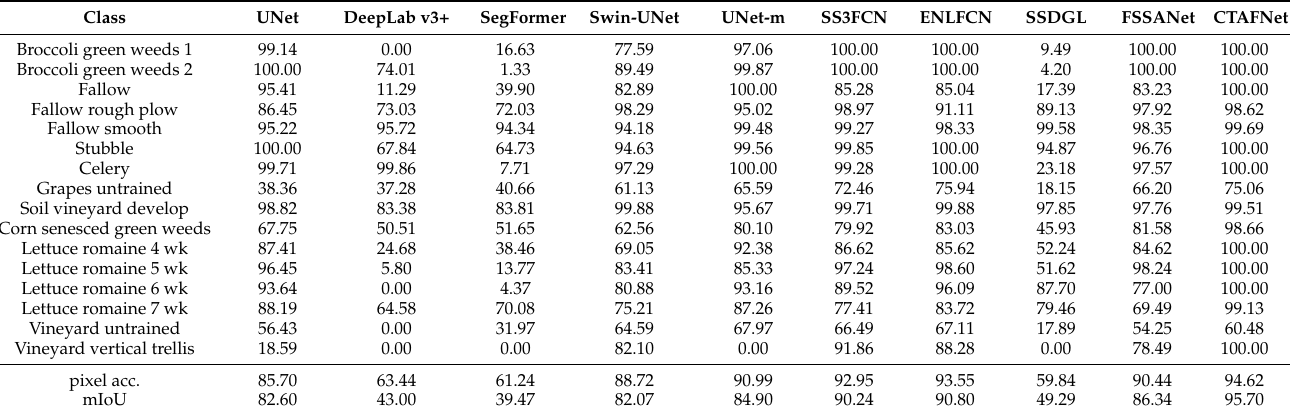
Table 11. Comparison of generalization performance on the Salinas